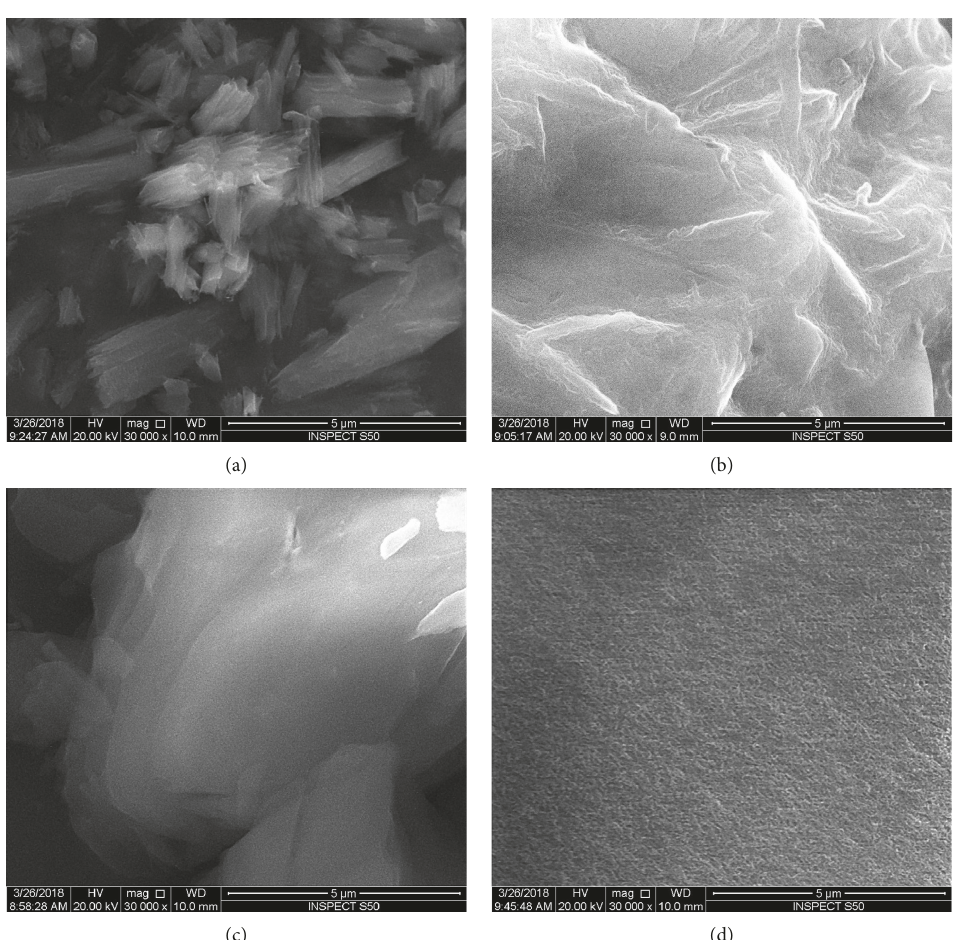
Figure 3: The surface morphology of the (qz) 4 Ni Pcs 4a–d samples prior to bacterial activities. SEM micrographs of (a) 4a , (b) 4b , (c) 4c , and (d) 4d . The samples show the different morphological features for different samples. All scale bars are 5 μ m.